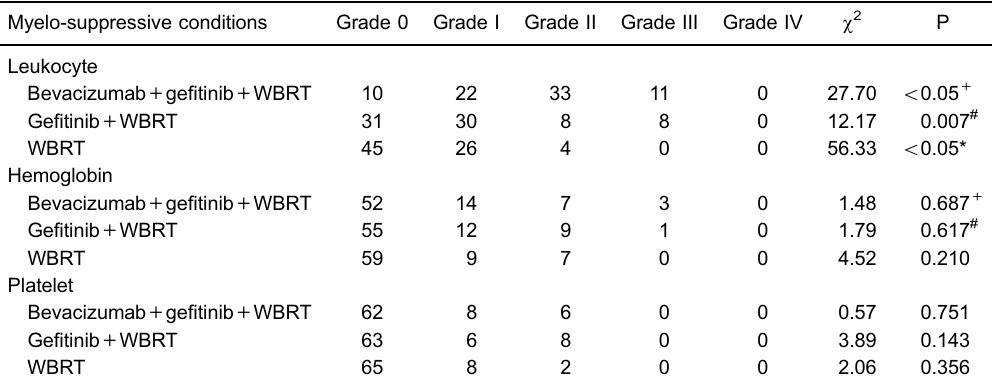
Table 4. Myelo-suppressive conditions in patients with brain metastases due to non-small-cell lung cancer treated with bevacizumab + ge fi tinib + WBRT, ge fi tinib + WBRT and WBRT. Myelo-suppressive